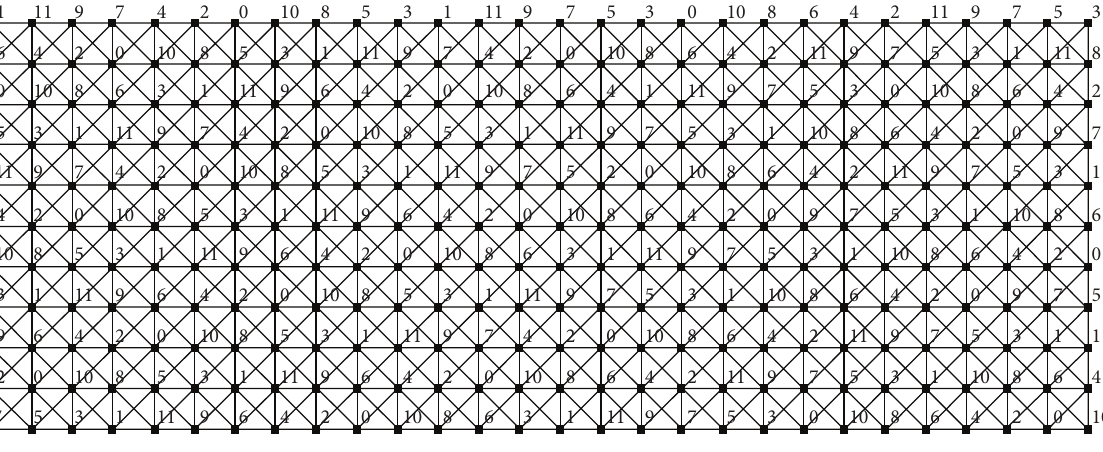
Figure 6: 11 - 𝐿(2, 1) -labeling of 𝐶 11 ⊠ 𝐶 28 .